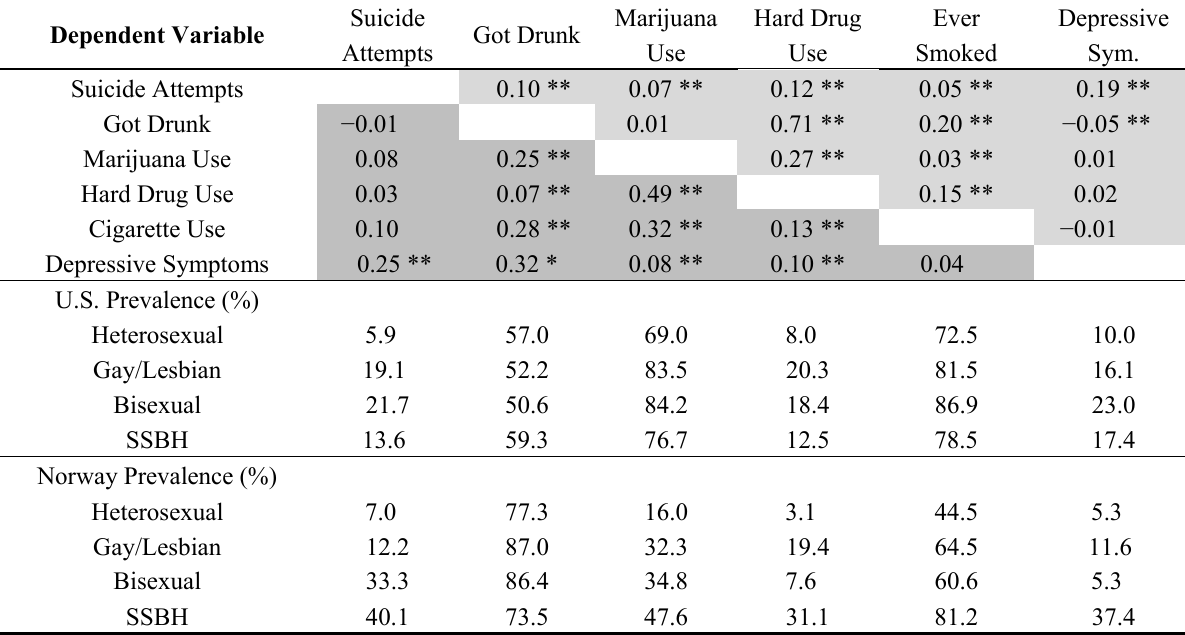
Norway Prevalence (%) Heterosexual